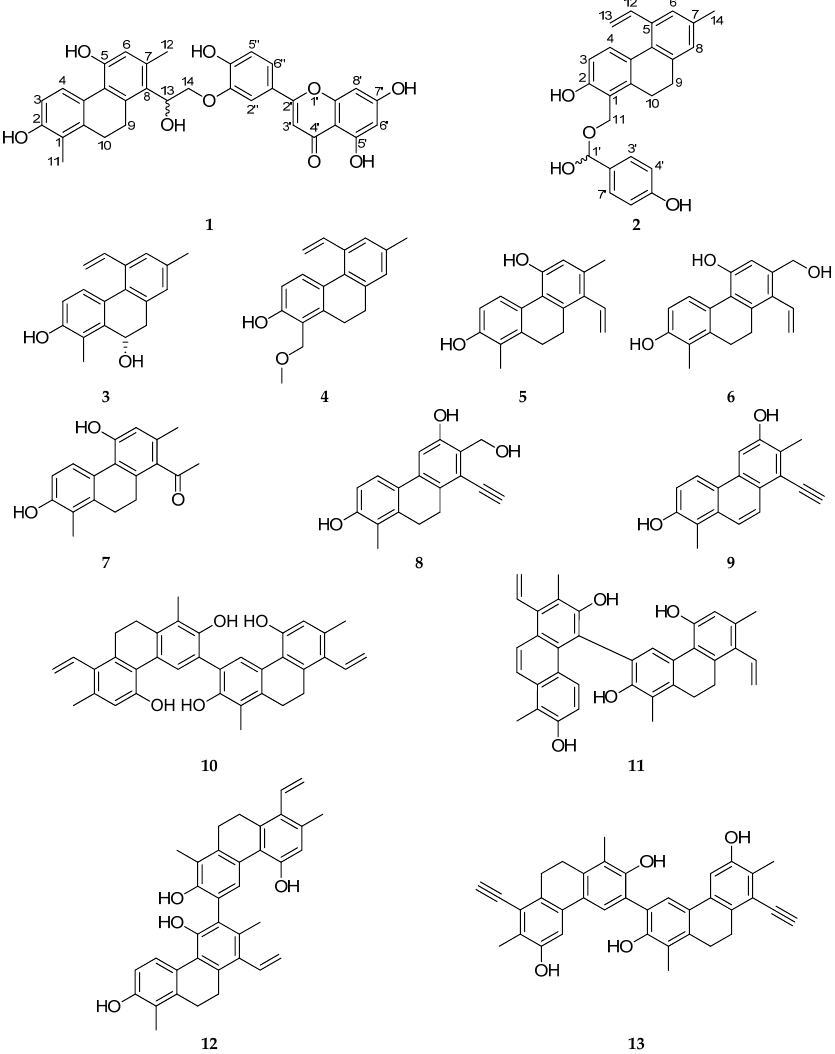
Figure 1. Structures of new compounds ( 1 – 13 ) isolated from J. ensifolius